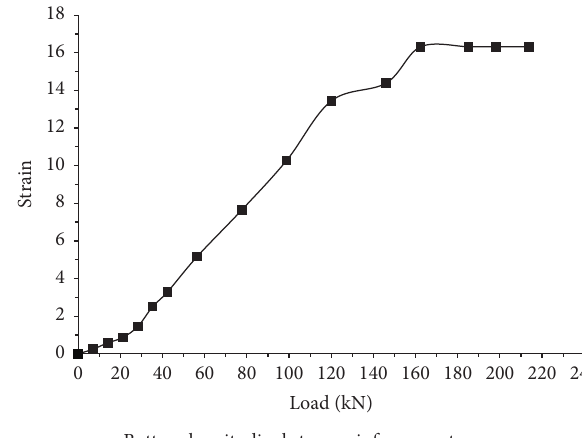
Figure 32: Deflection/curve relation curve of the midspan of the tensile